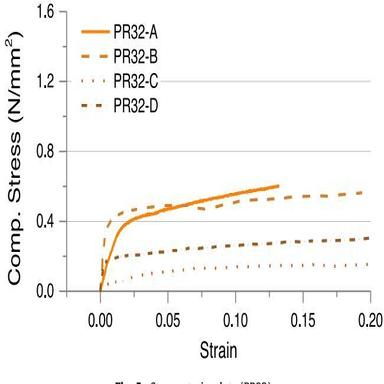
Stress–strain plots (PR32).